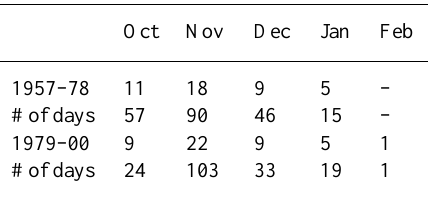
Frequencies of appearances of ELO 3 events ( (cid:127) < 220 matm-cm) and their overall duration (days) over the N.Atlantic/European sector during the 1957–1978 and 1979–2000